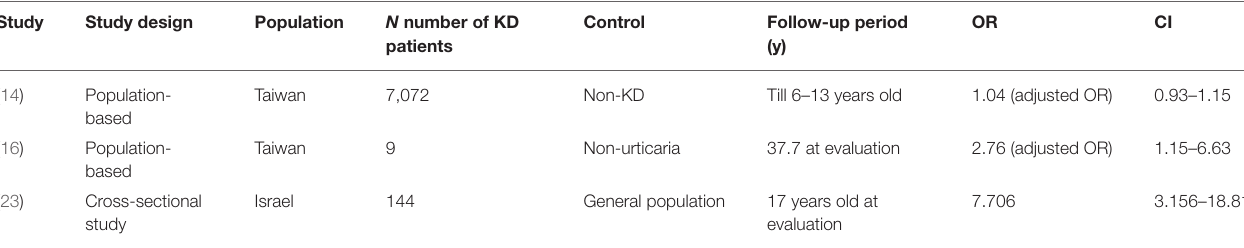
TABLE 4 | Effect of Kawasaki disease on